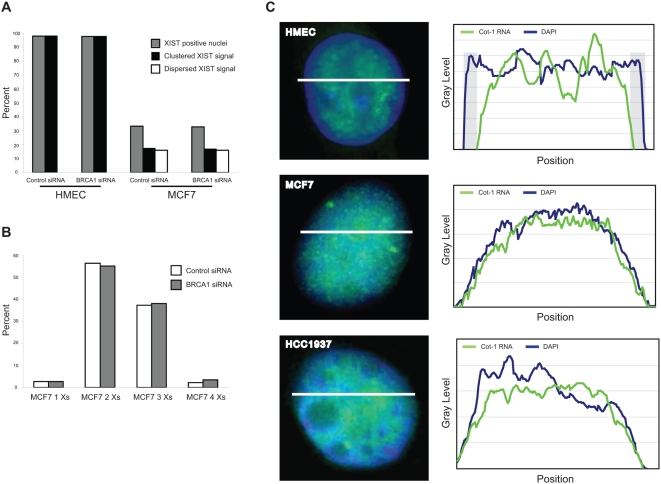

XIST RNA staining patterns and global defects of heterochromatin are independent of BRCA1 status.A) Percentages of nuclei positive for XIST RNA signal before and after BRCA1 silencing in HMEC and in MCF7. Specific signal morphology was evaluated, distinguishing clustered and dispersed signals. HMEC always display clustered staining only. In both cell types no relevant variation was observed after siRNA treatment. The results were reproducible in independent experiments. B) Distribution of MCF7 cell populations respect to X chromosome numbering before and after BRCA1 knockdown. No relevant variation in the relative content of the different populations was observed after siRNA treatment. The results were reproducible in independent experiments. C) Analysis of heterochromatin status in BRCA1 normal and mutant cells by FISH analysis with Cot-1 probe (green) on DAPI-stained nuclei. A line scan of fluorescence intensity (white bars) is shown for each cell type. Shaded areas indicating regions of peripheral heterochromatin are evident in the scan plot relative to HMEC, but not in those of MCF7 (BRCA1wt) and HCC1937 (BRCA1−/−) breast cancer cell lines.